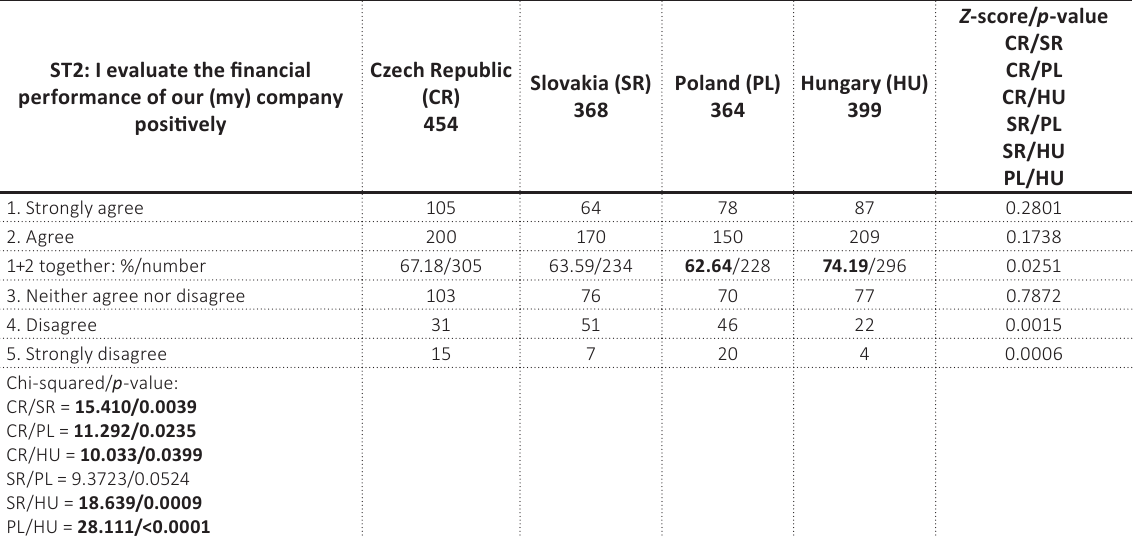
Source: Own research.